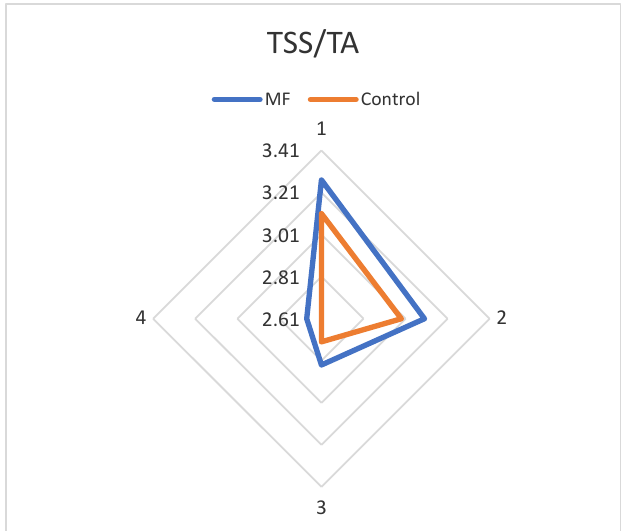
Figure 12. Effects of MF on the respiration rate of Idared apples.